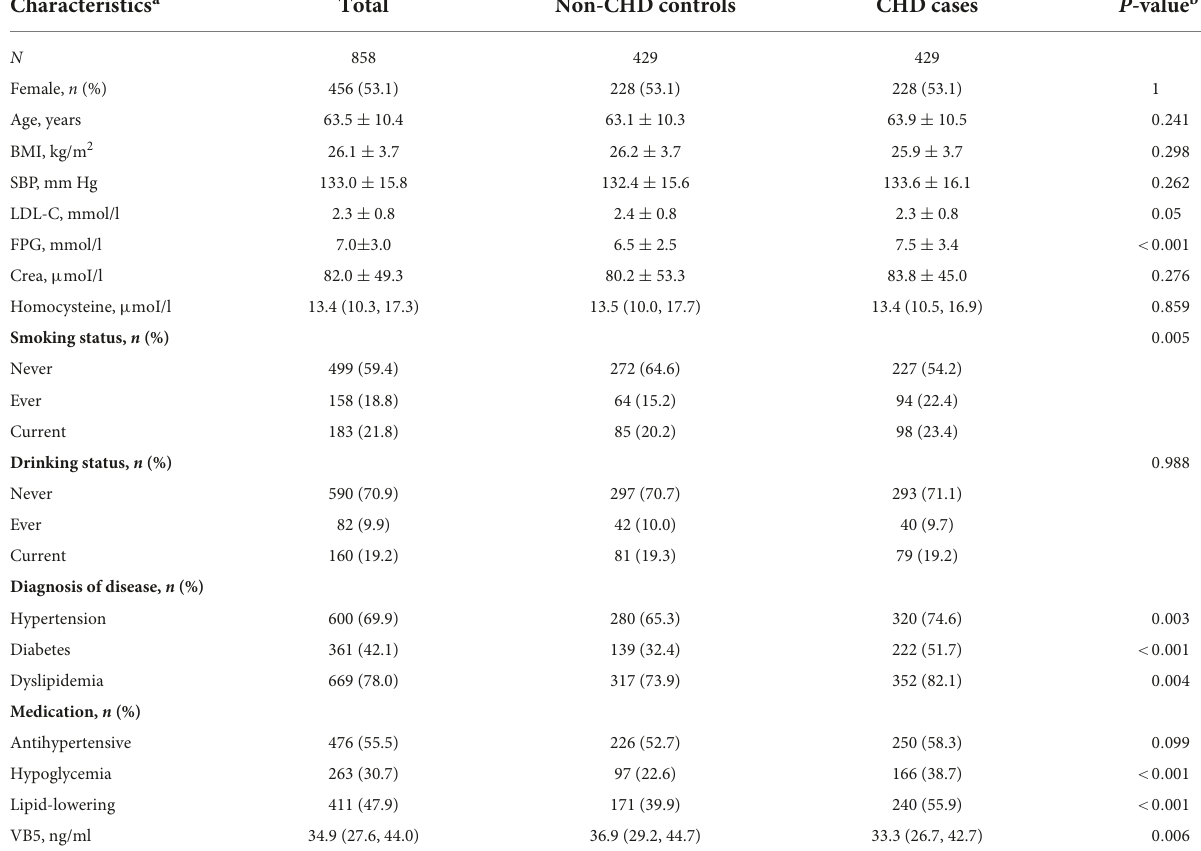
TABLE 1 Characteristics of cases and